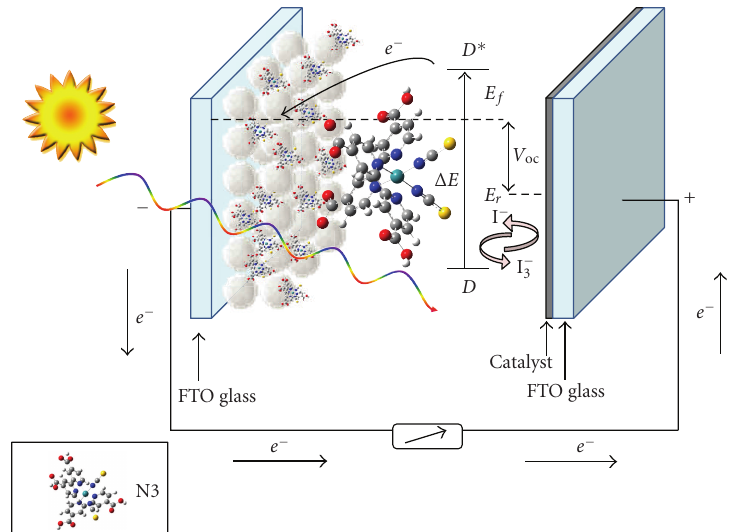
Figure 1: Schematic representation of the DSSC, based on a dye ruthenium-based (N3), to indicate the electron energy level and electron flux in di ff erent processes. The cell voltage (V oc ) observed under illumination corresponds to the di ff erence (cid:2) V between the quasi-Fermi level of titanium and the electrochemical potential of the